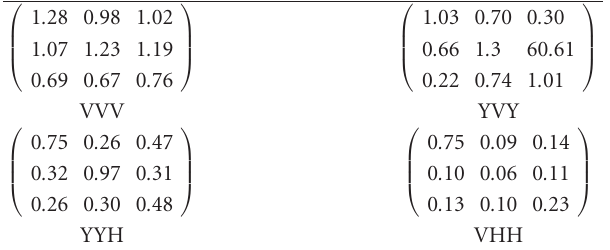
Table 7: Normalized power for di ff erent polarization schemes in indoor NLOS environment. ⎛ 0 . 80 1 . 00 1 . 09 ⎜ ⎜ ⎝